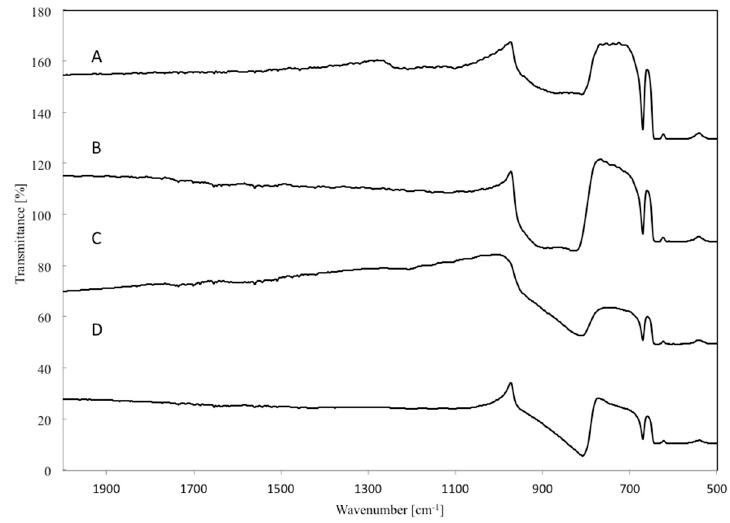
Figure 8. FTIR spectra for (A) β -SiC; (B) (5) W x C- β -SiC; (C) (10) W x C- β -SiC and (D) (20) W x C- β -SiC catalyst.